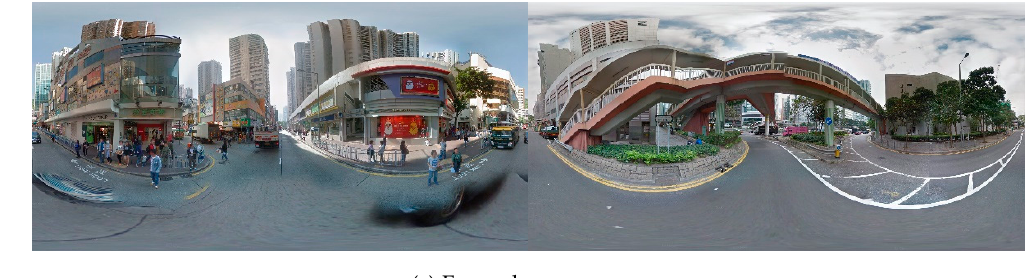
Figure 8. Example street view images and query images.